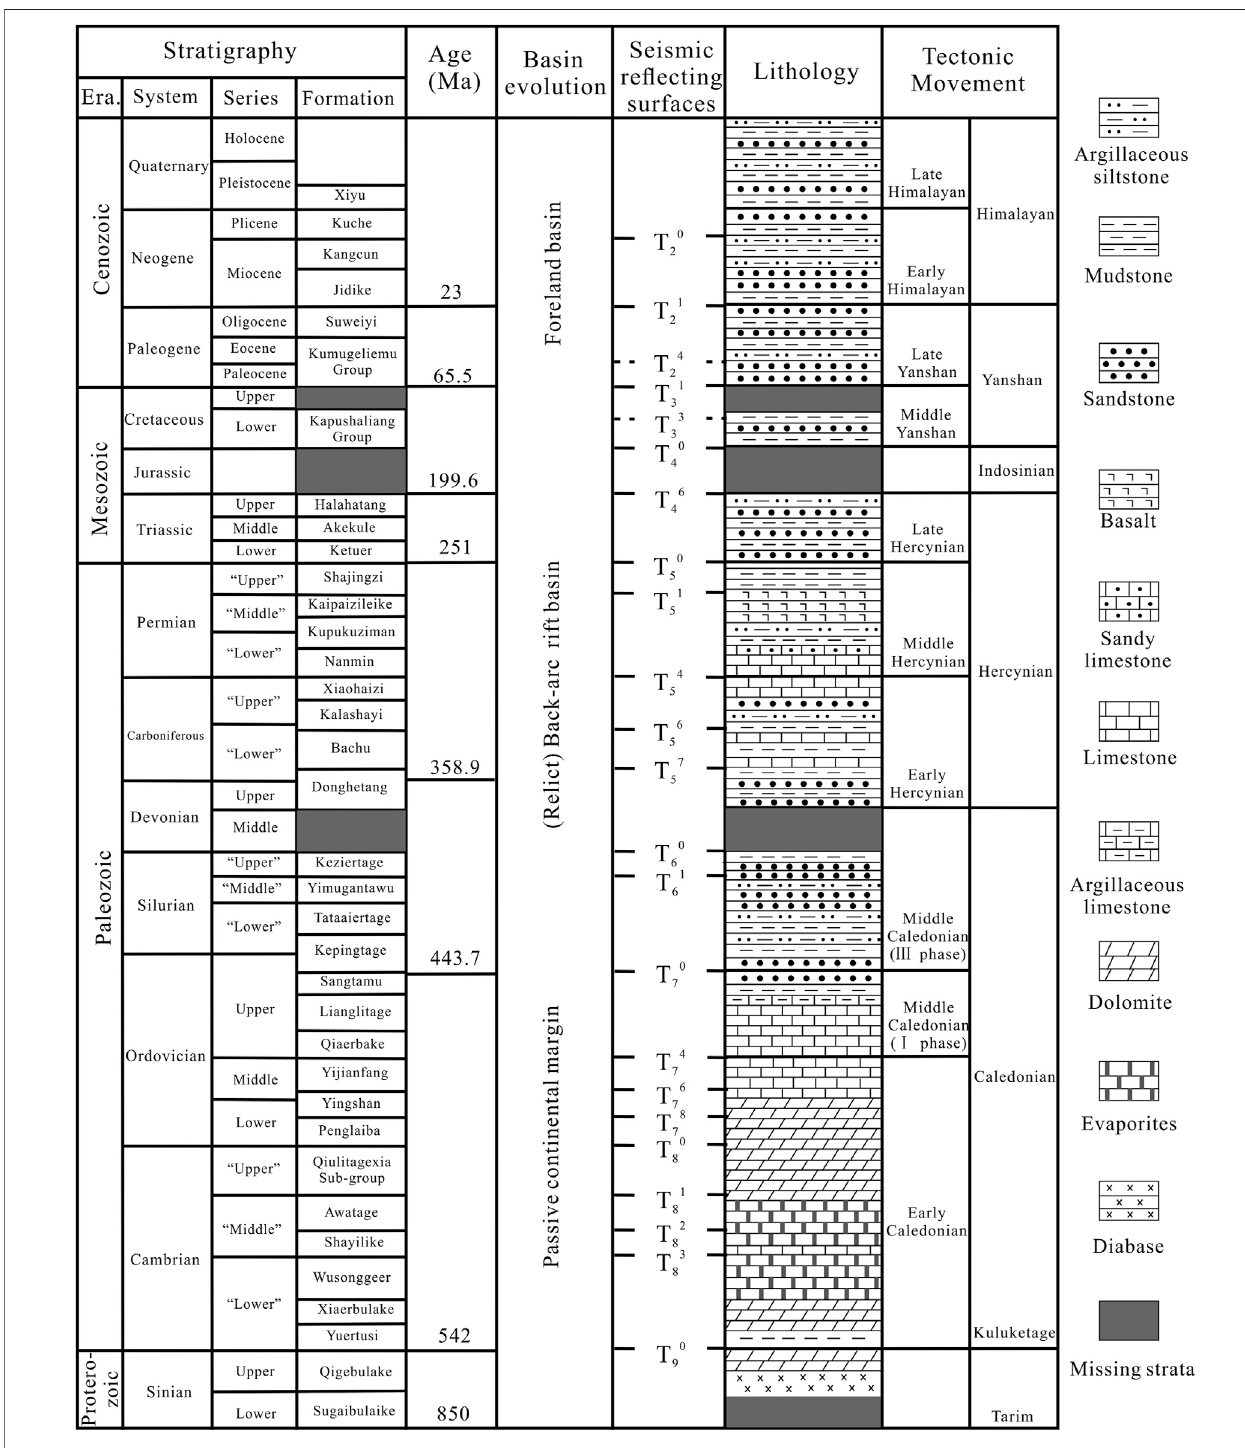
FIGURE3 | Generalizedstratigraphy ofthe Shunbei 5strike-slip deformation beltin Tarim Basin(Modi fi ed after Luet al., 2015; Deng et al., 2019; Hanet al., 2021).